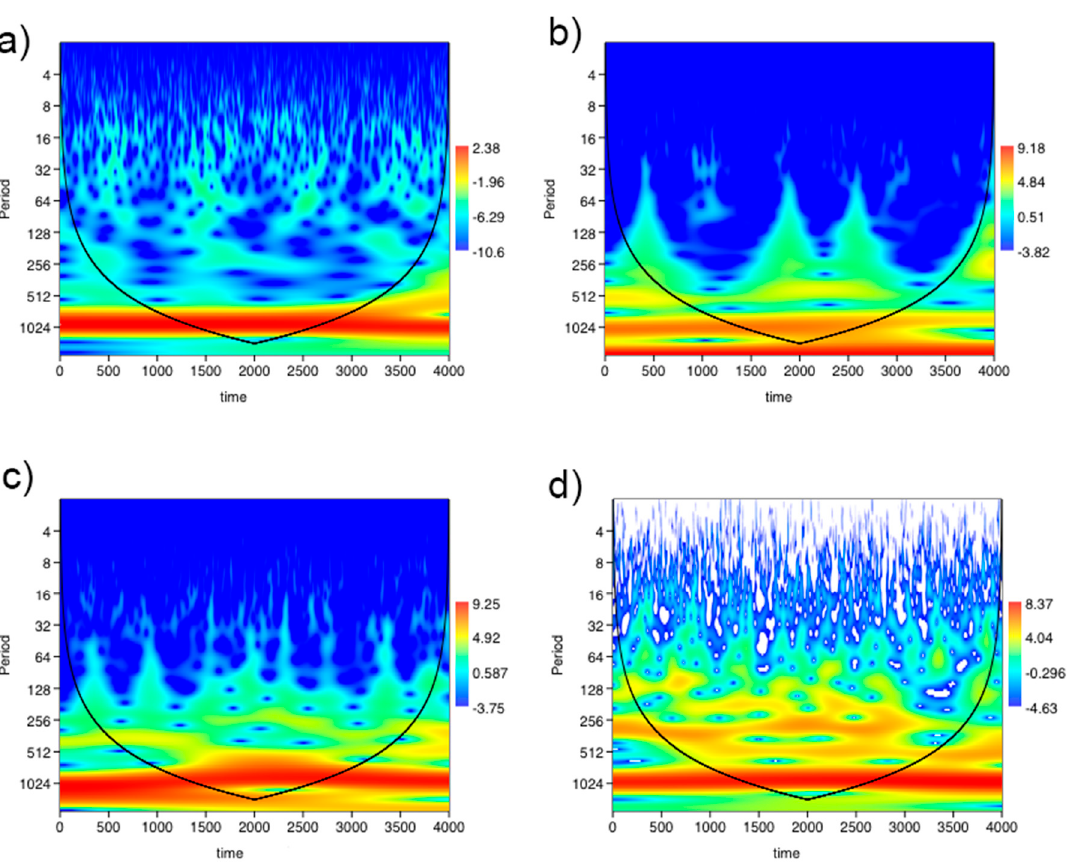
Figure 7. WT scalograms of the solutions of Equation (19) for a = 0.3 and α = 0.10 ( a ) , 0.25 ( b ) , 0.40 ( c ) and 0.55 ( d ). In abscissa the simulation in time steps and in ordinate periods is reported.